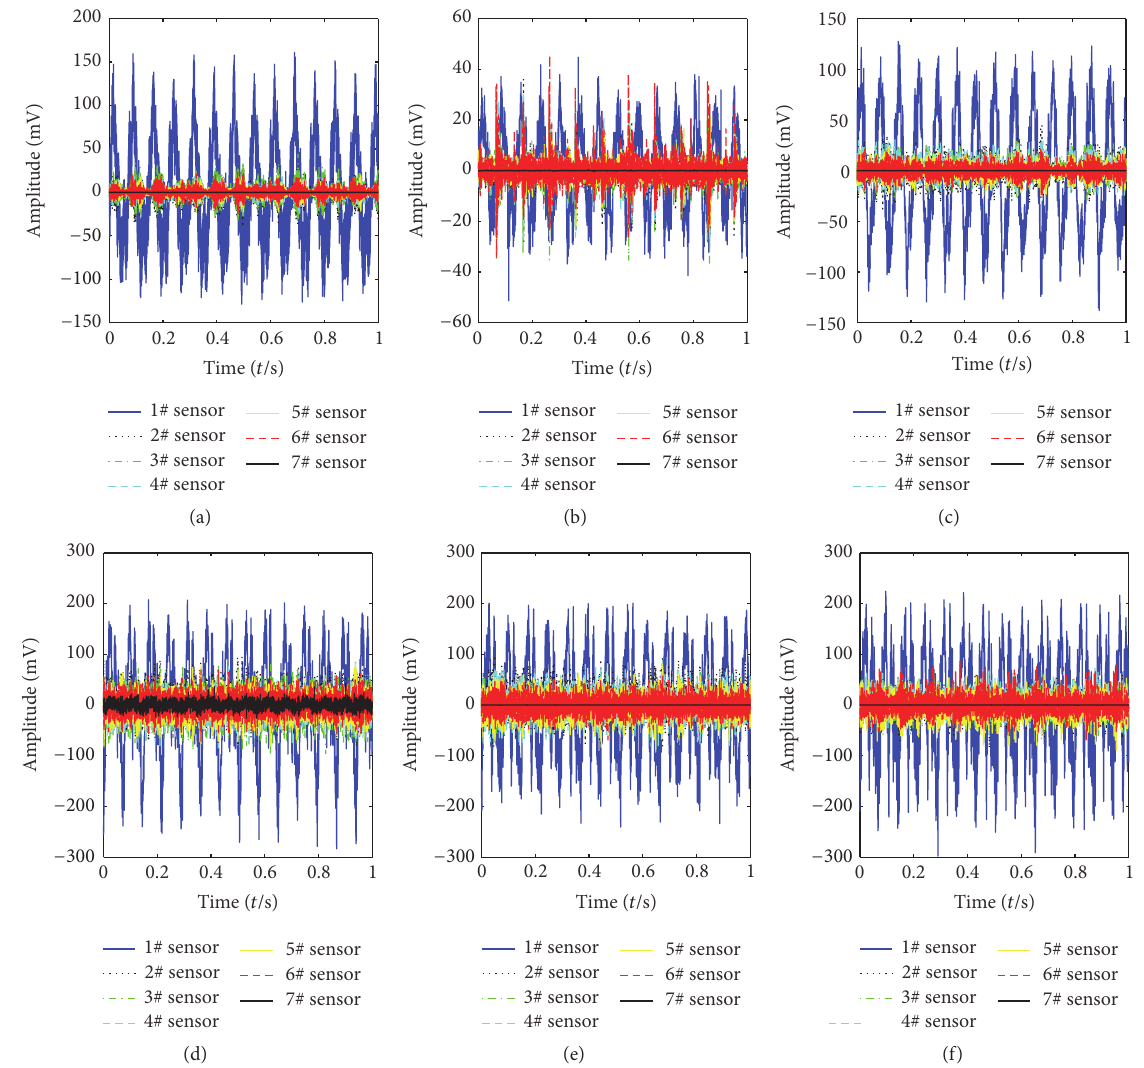
Figure 3: Test signals originating from the seven different sensors under the following conditions: (a) Norm, (b) C G, (c) B G, (d) W P, (e) B G C W P, and (f) C G C W P.